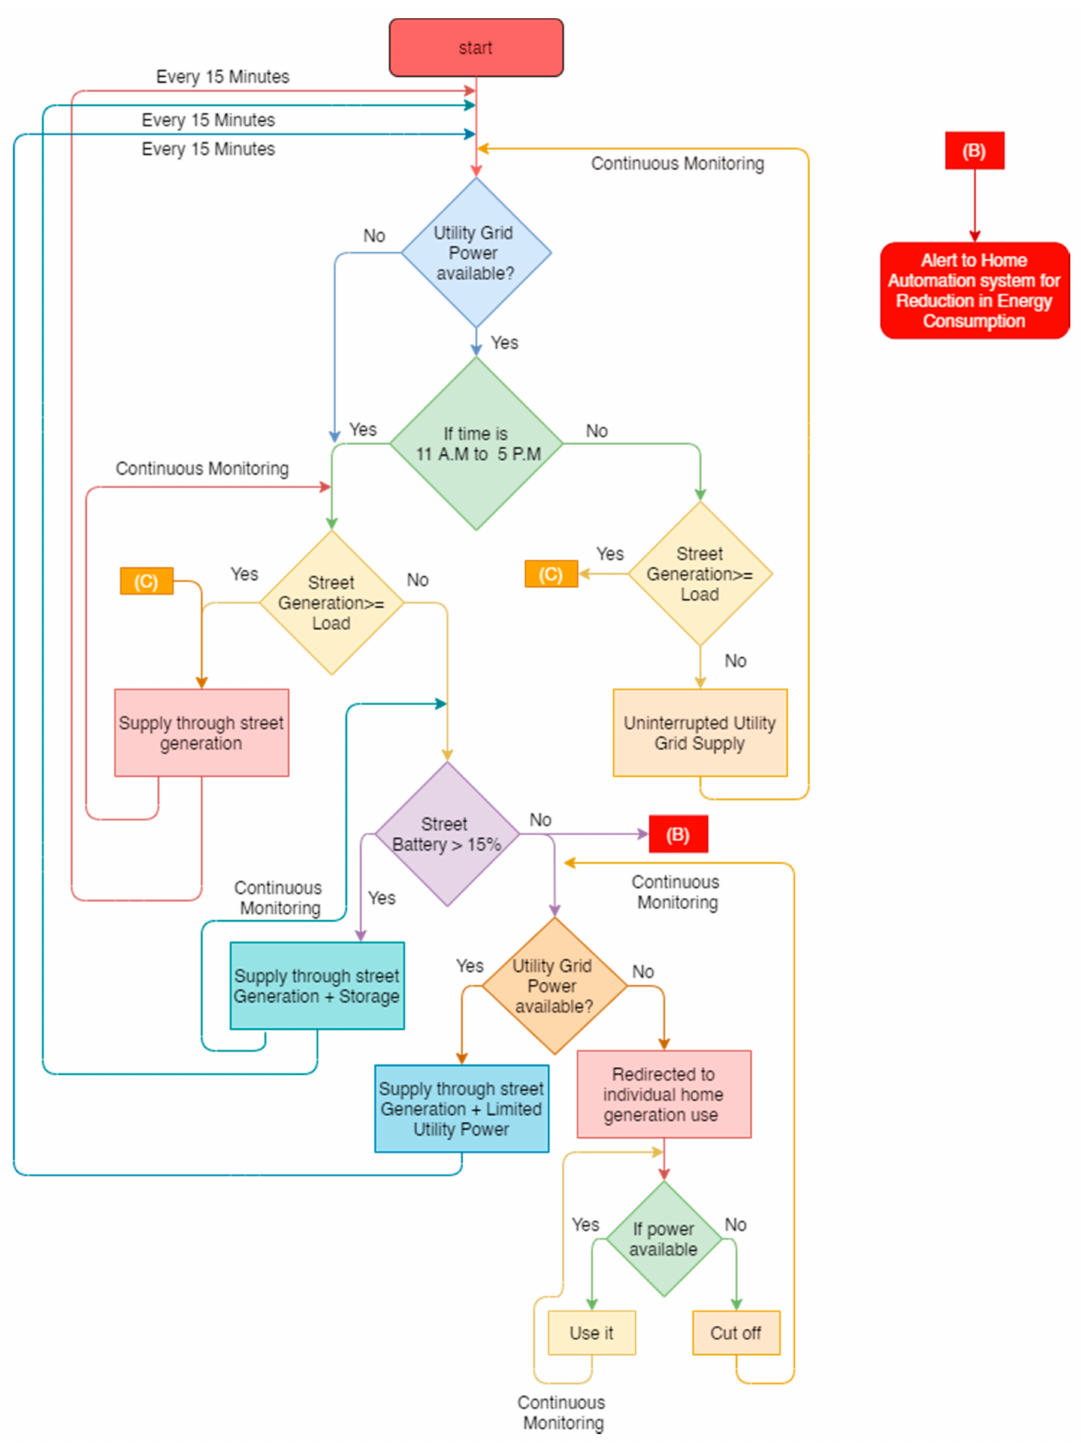
Figure 4. Electrical Energy Flow Algorithm for the